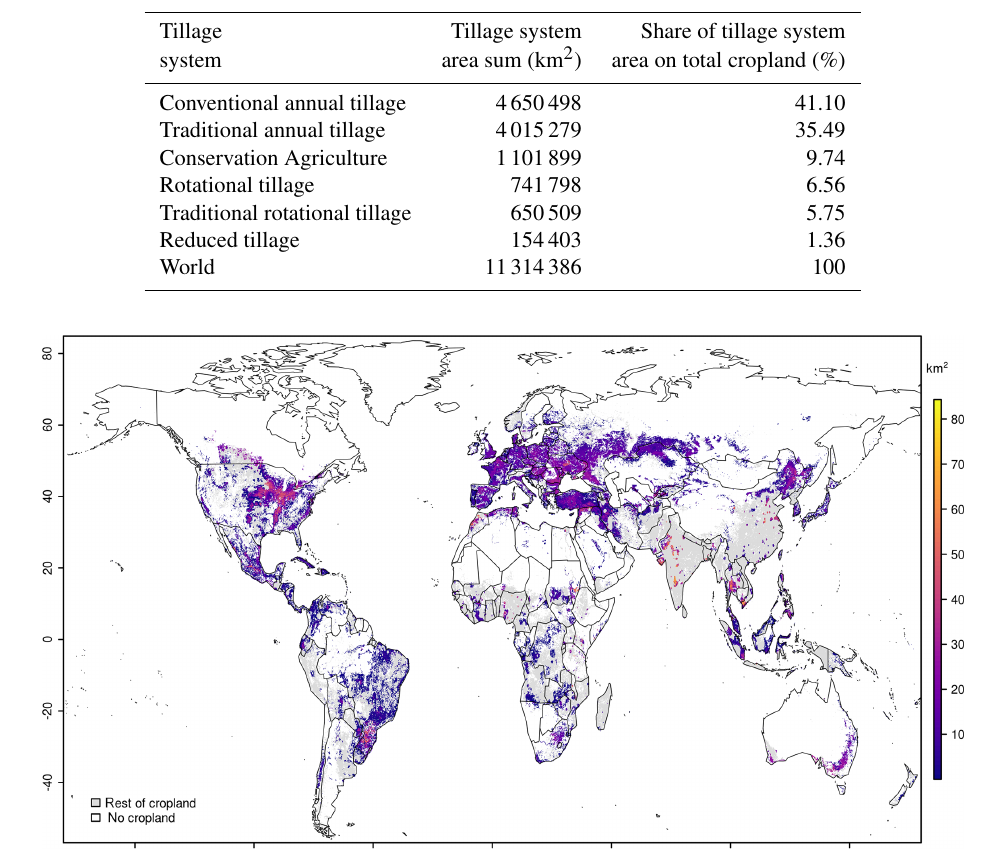
Figure 2. Conventional annual tillage area, which has been allocated to the majority of the global physical cropland